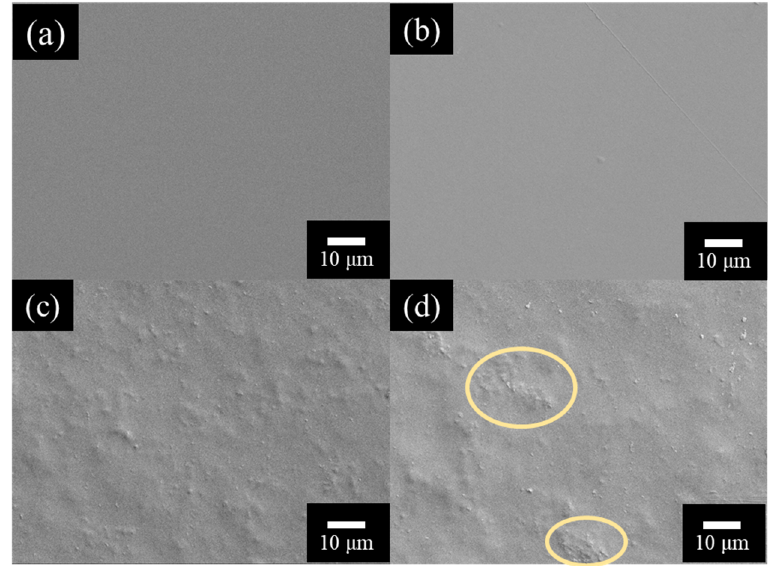
Figure 3. The surface of hemp/PVA composite films with different hemp particle weight ratios ( a ) 0%, ( b ) 1%, ( c ) 5%, ( d ) 10%.